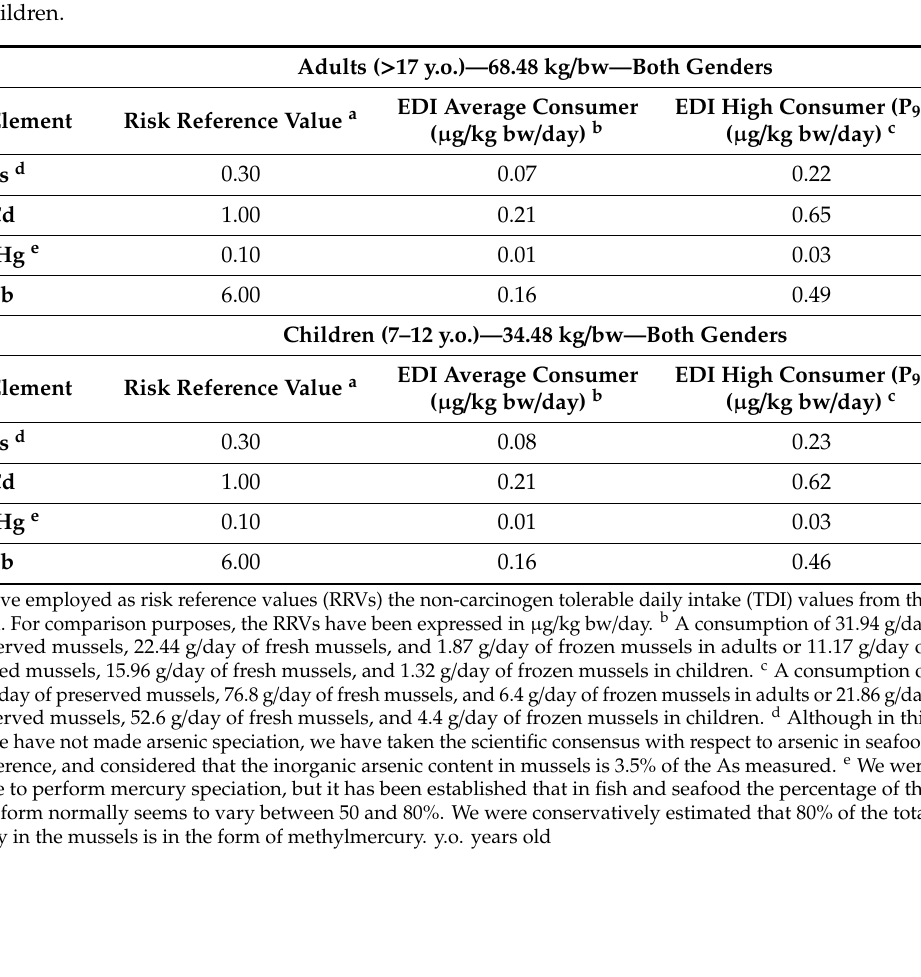
Table 5. Estimated daily intake of major toxic elements through the consumption of mussels in adults and